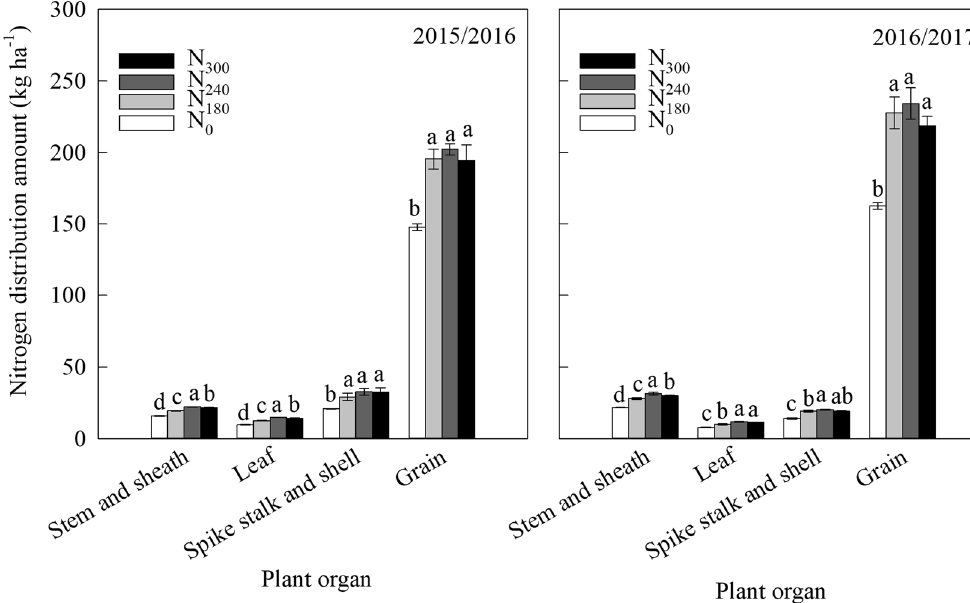
Figure 2. Amount of N distribution in wheat at maturity under different N treatments in 2015/2016 and 2016/2017 (kg ha − 1 ). N 300 , N 240 , N 180 and N 0 represent N application rate at 300, 240, 180 and 0 kg N ha − 1 , respectively. Vertical bars represent standard deviation of the means. Different letters indicate statistical significance at P < 0.05 among treatments.